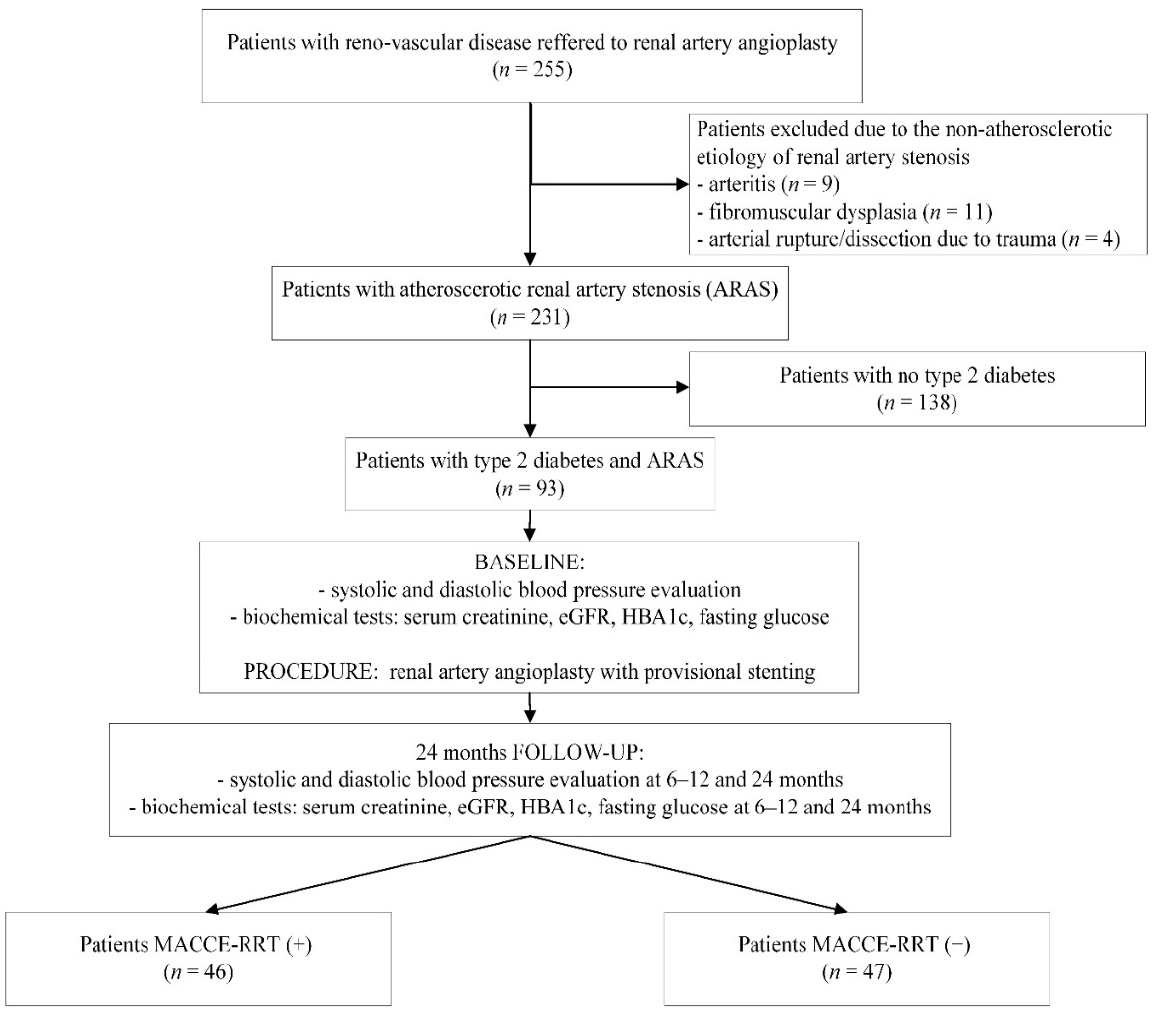
Figure 1. Study flowchart.